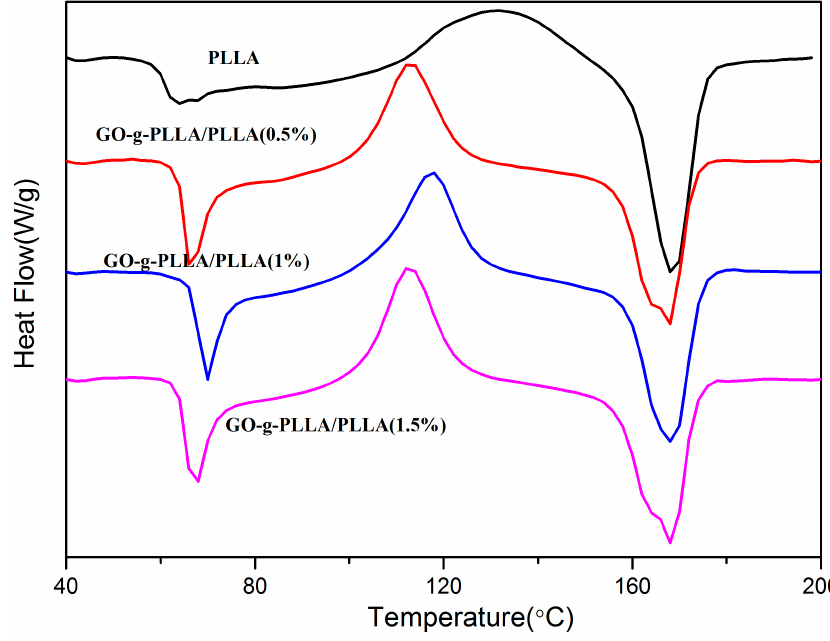
Figure 9. Differential scanning calorimetry (DSC) curves of PLLA and GO- g -PLLA/PLLA. Table 1. The glass transition temperature (Tg), melting temperature (Tm), enthalpy of melting ( Δ Hm), and degree of crystallinity (Xc) of PLLA and GO- g -PLLA/PLLA.